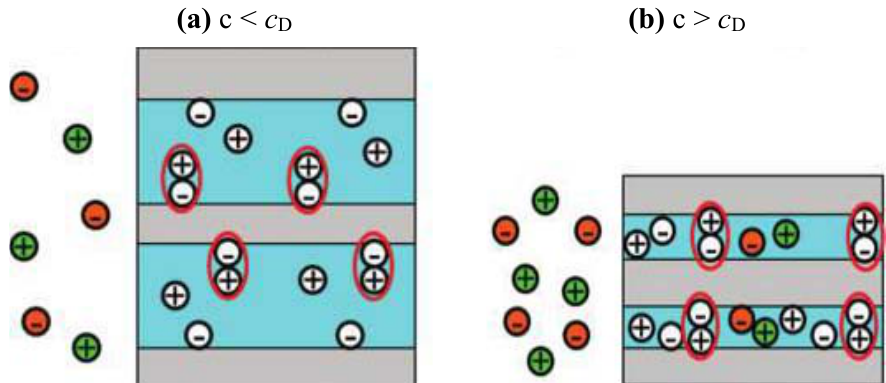
Figure 4. Schematic representation of the influence of an equilibrated medium concentration on the polymer electrolyte membrane structure ( a ) concentrations lower and ( b ) greater than the Donnan concentration c reference